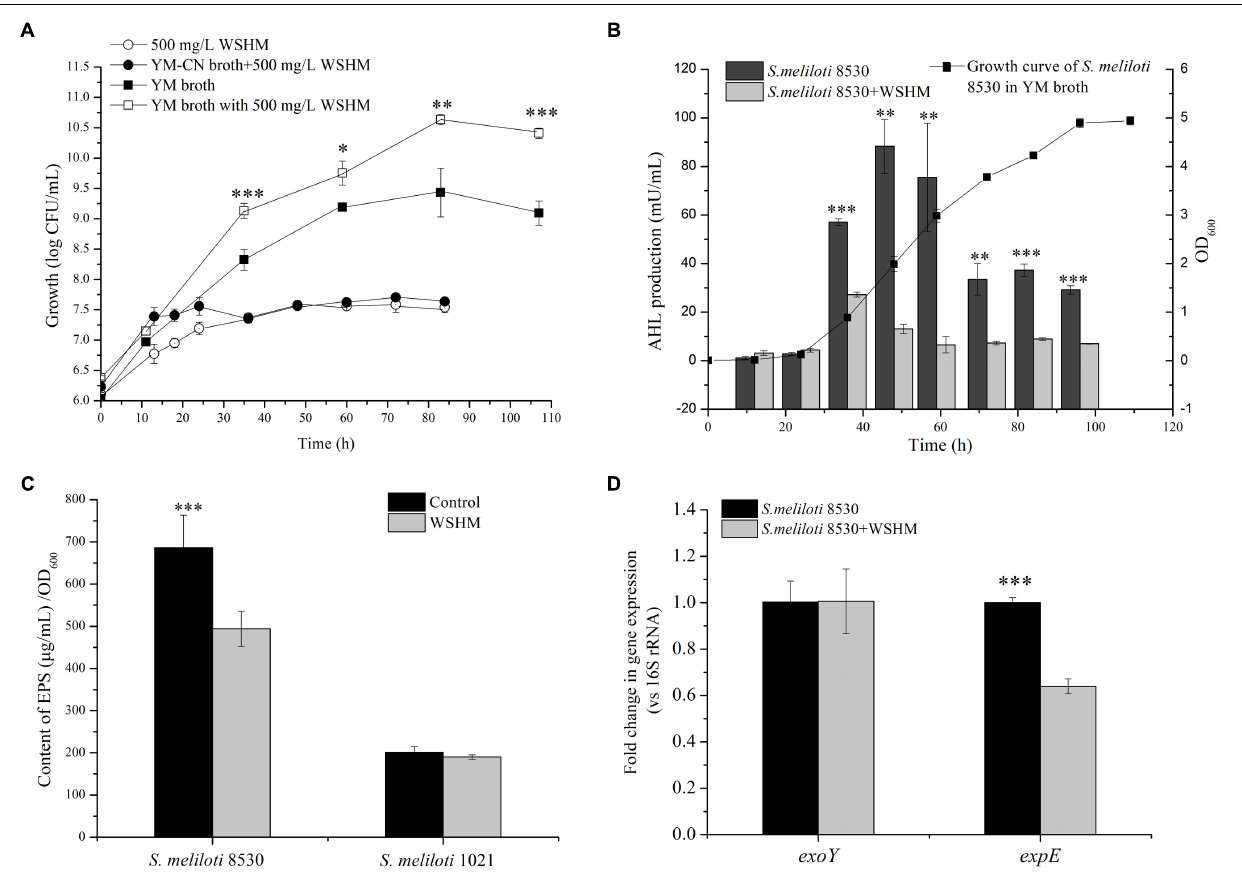
FIGURE 2 | Effects of WSHM on the growth (A) , AHL production (B) , exopolysaccharide production (C) , and exoY and expE gene expression (D) in S. meliloti 8530. All the data are expressed as average ± standard deviation (SD) ( n = 3). Statistical significance was assessed by Student’s t -tests ( ∗ P < 0.05; ∗∗ P < 0.01; ∗∗∗ P < 0.001). For exopolysaccharides production (C) , S. meliloti 1021 ( (cid:49) expR ) was also included. (A) YM-CN broth: the nitrogen (yeast extract) and carbon (mannitol) source in YM broth were